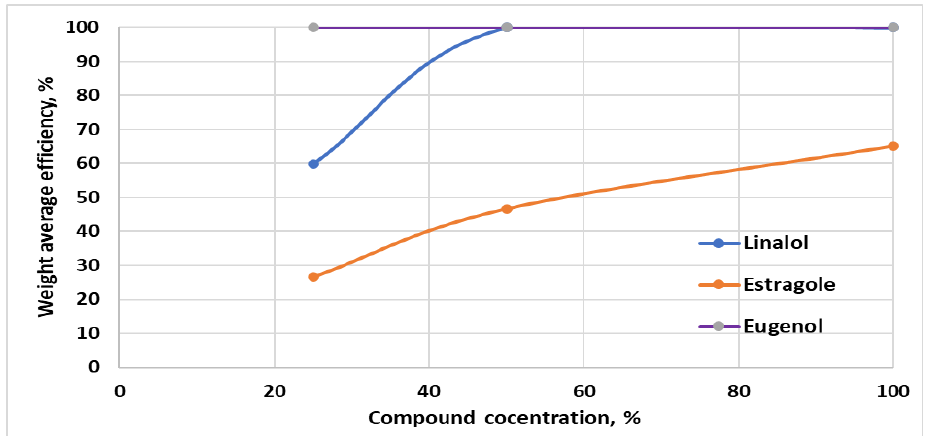
Figure 14. The dependence of the average temporal efficacy on the concentration, for linalool, es- tragole, and eugenol, on the B. cinerea. estragole, and eugenol, on the B.